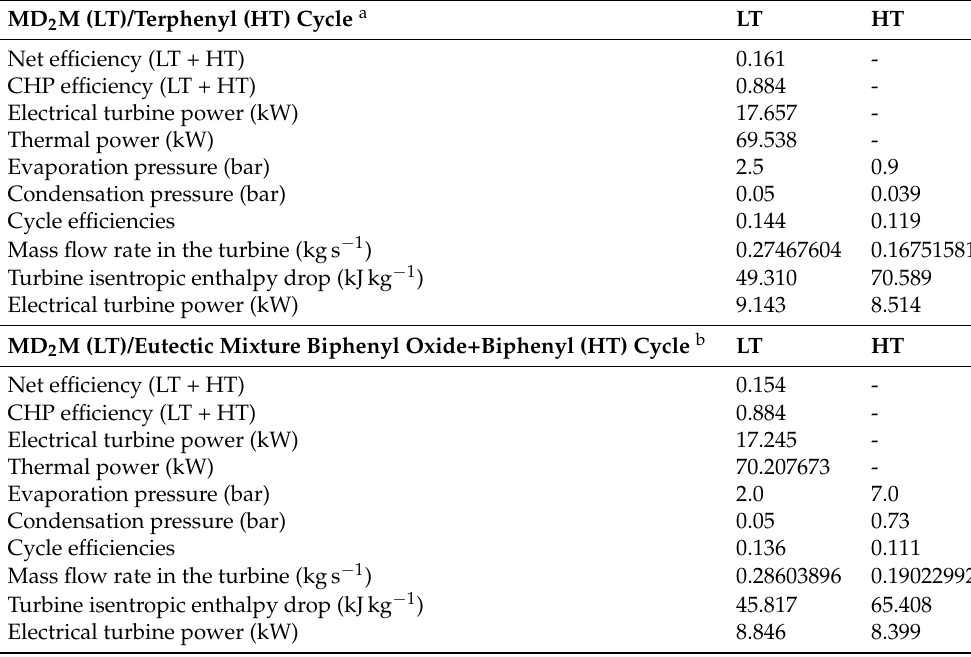
Table 4. Some results for binary cycles.